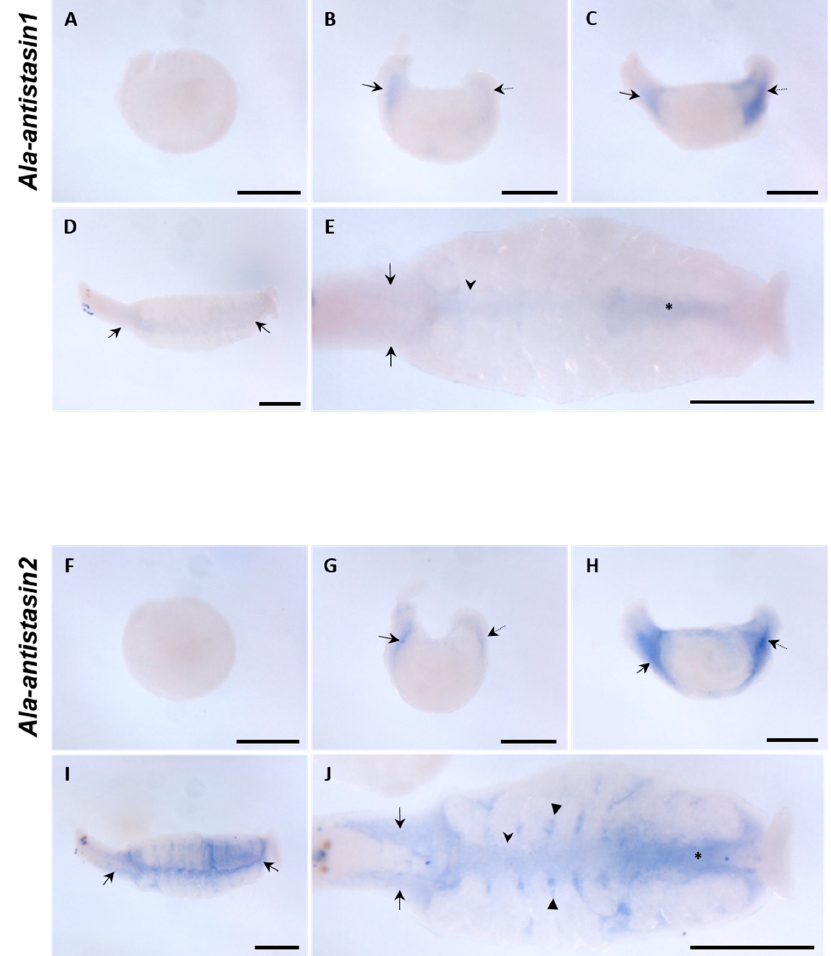
Figure 4. Spatial expression pattern of Ala-antistasin transcripts in Alboglossiphonia lata embryos. ( A, B, C, F, G , and H ) Ala-antistasin1 and Ala-antistasin2 are expressed in the same region until stage 11. At stage 9, the two antistasin transcripts are not expressed. At stage 10, antistasin transcripts are expressed in the predicted salivary gland region (black arrow) and hindgut (black dot arrow). During middle stage 11, the same expression appears stronger at the same location. D and E ) At late stage 11, Ala-antistasin1 is expressed in the salivary gland region (black arrow), midgut (black arrowhead), and hindgut (black asterisk). ( I and J ) Ala-antistasin2 is expressed intensely in the salivary gland (black arrow), midgut (black arrowhead), cecae boundary (black triangle), and hindgut (black asterisk). Scale bar in all images 200 μ m.